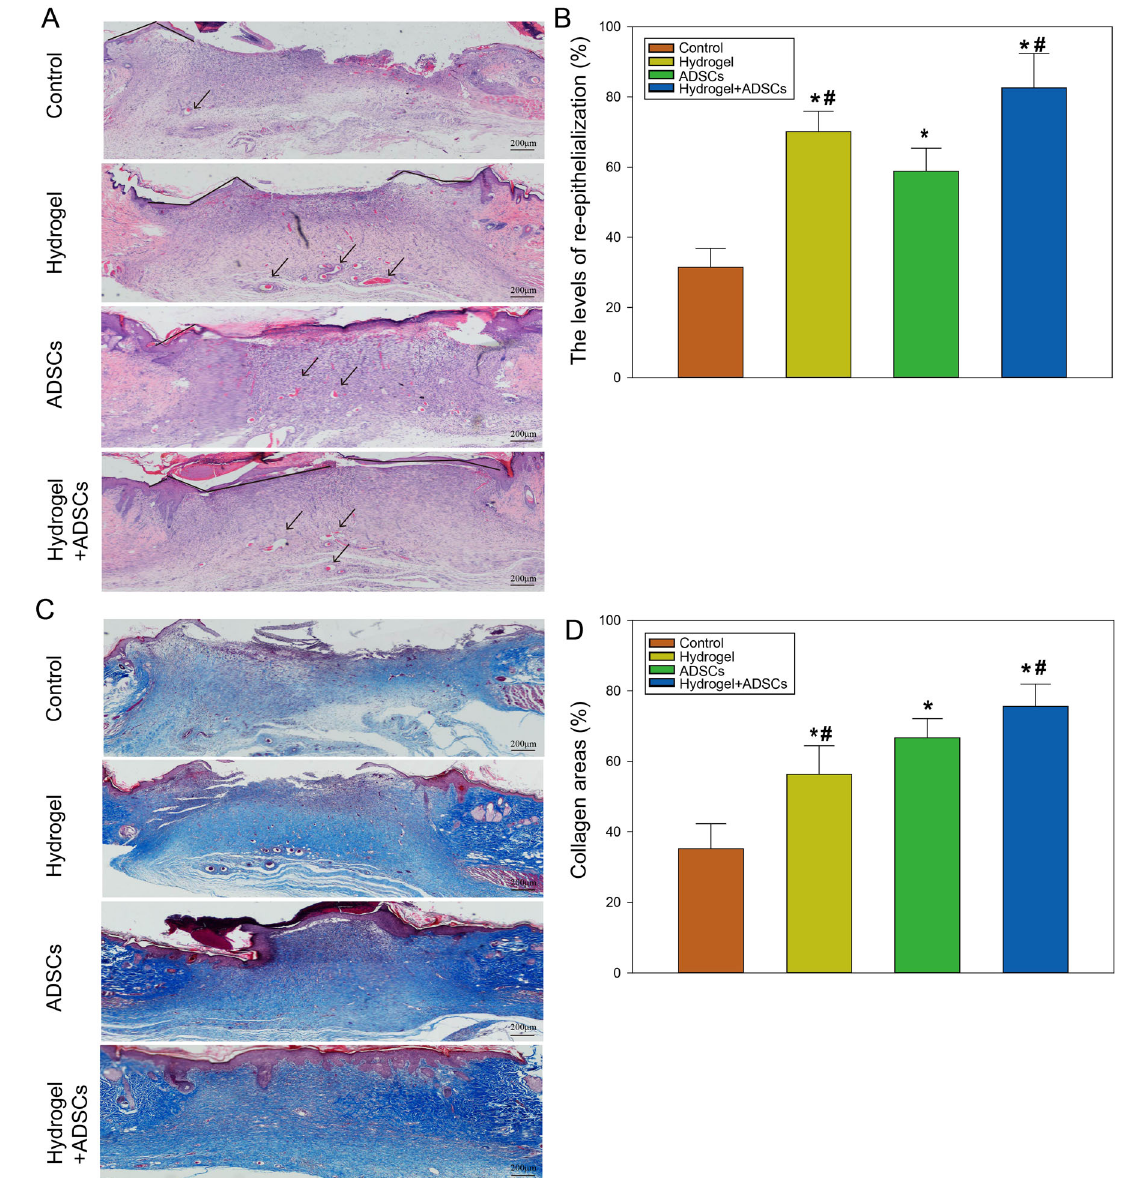
Fig. 4 ADSCs-loaded β -ChNF hydrogel accelerated wound healing and collagen deposition in rats. A Representative H&E staining images of each group. The red arrows indicated new blood vessels. B Image J software was used to measure the levels of re-epithelialization of the full-thickness wounds in each group. * P < 0.05, vs. the control group; # P < 0.05, vs. the ADSCs group; & P < 0.05, vs. the ADSCs + hydrogel